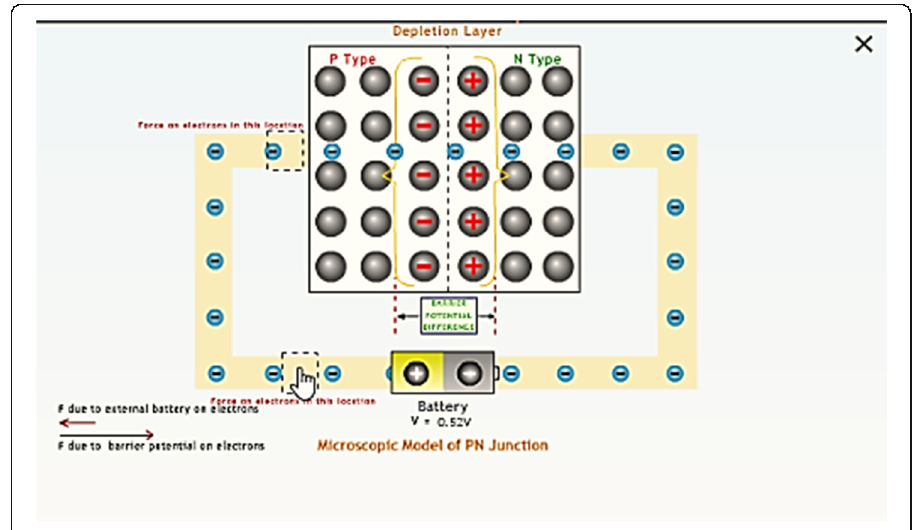
Fig. 3 Simulation of the microscopic